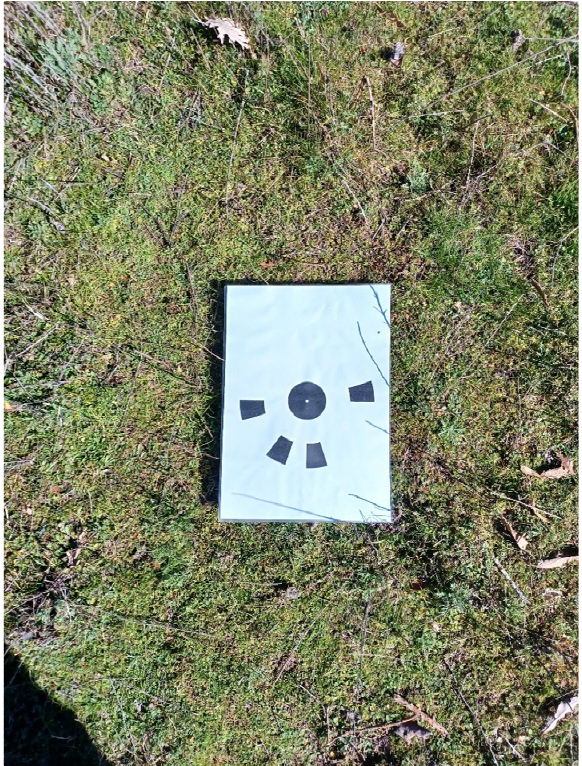
Figure 2. Printed GCP pattern, distributed throughout the survey area during UAV campaigns.